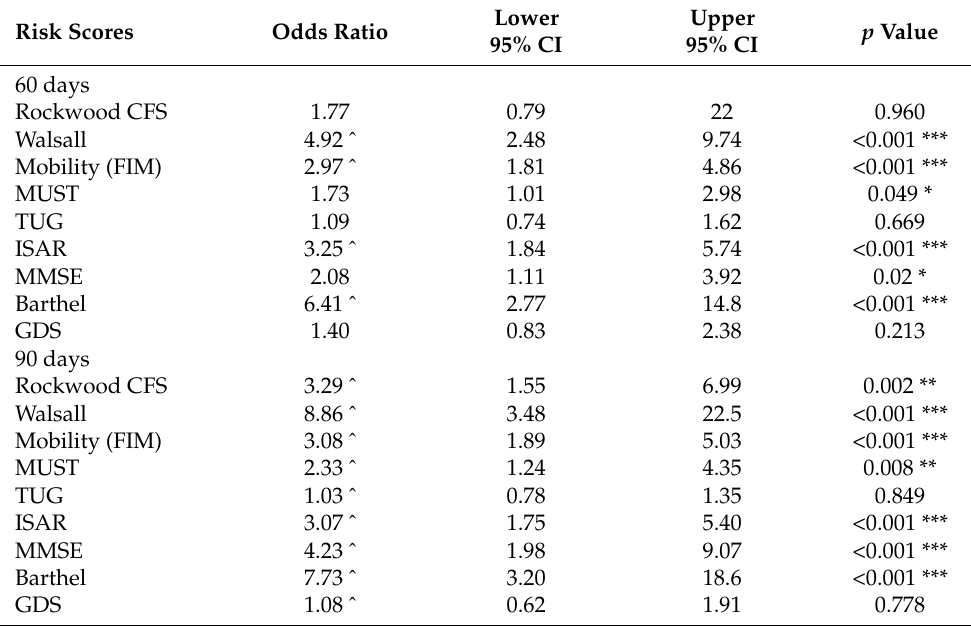
Lower Upper p Value 95% CI 95% CI